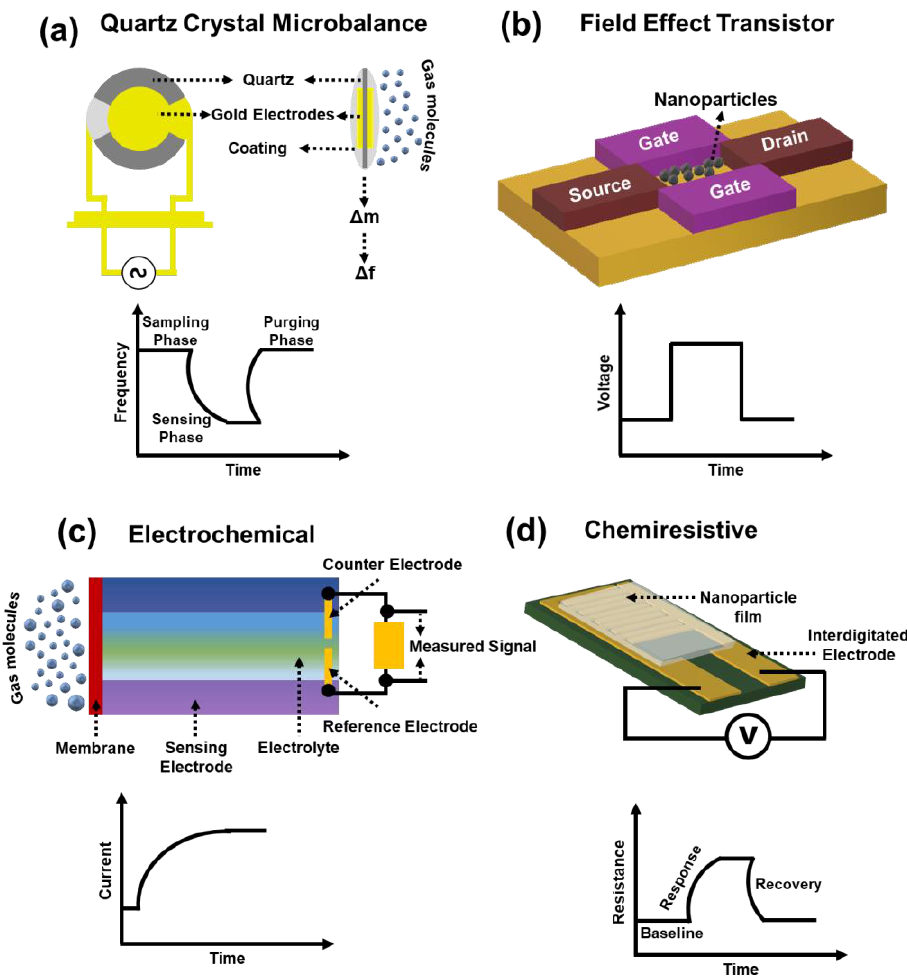
Figure 3. Simplified schematic illustrations of different transduction mechanisms utilized in Enoses systems: ( a ) QCM, ( b ) FET, ( c ) electrochemical, ( d ) chemiresistive.